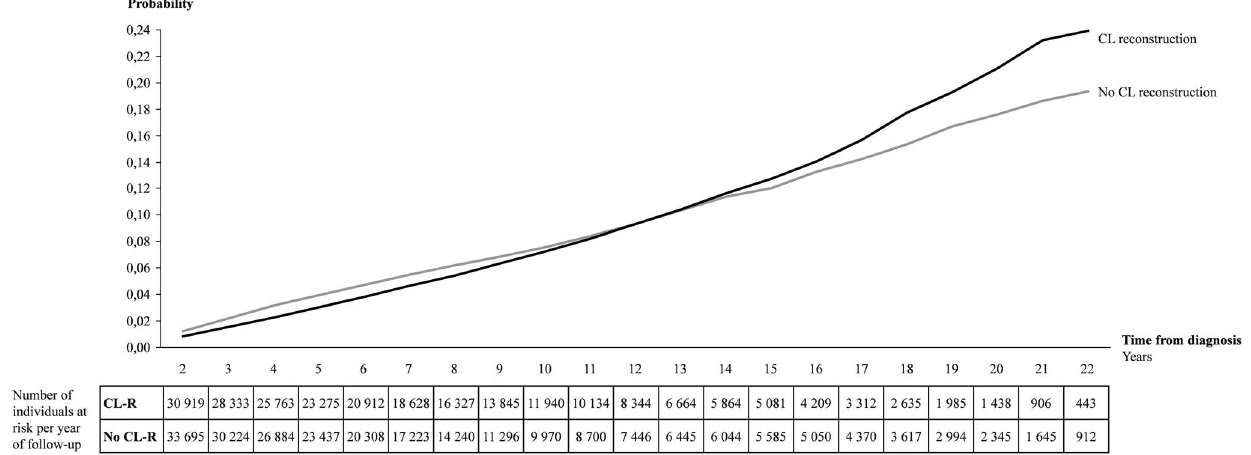
Figure 1. Cumulative incidence for osteoarthritis in the knee among 33,695 patients with CL diagnosis treated non-operatively and 30,919 patients with CL diagnosis treated surgically in Sweden